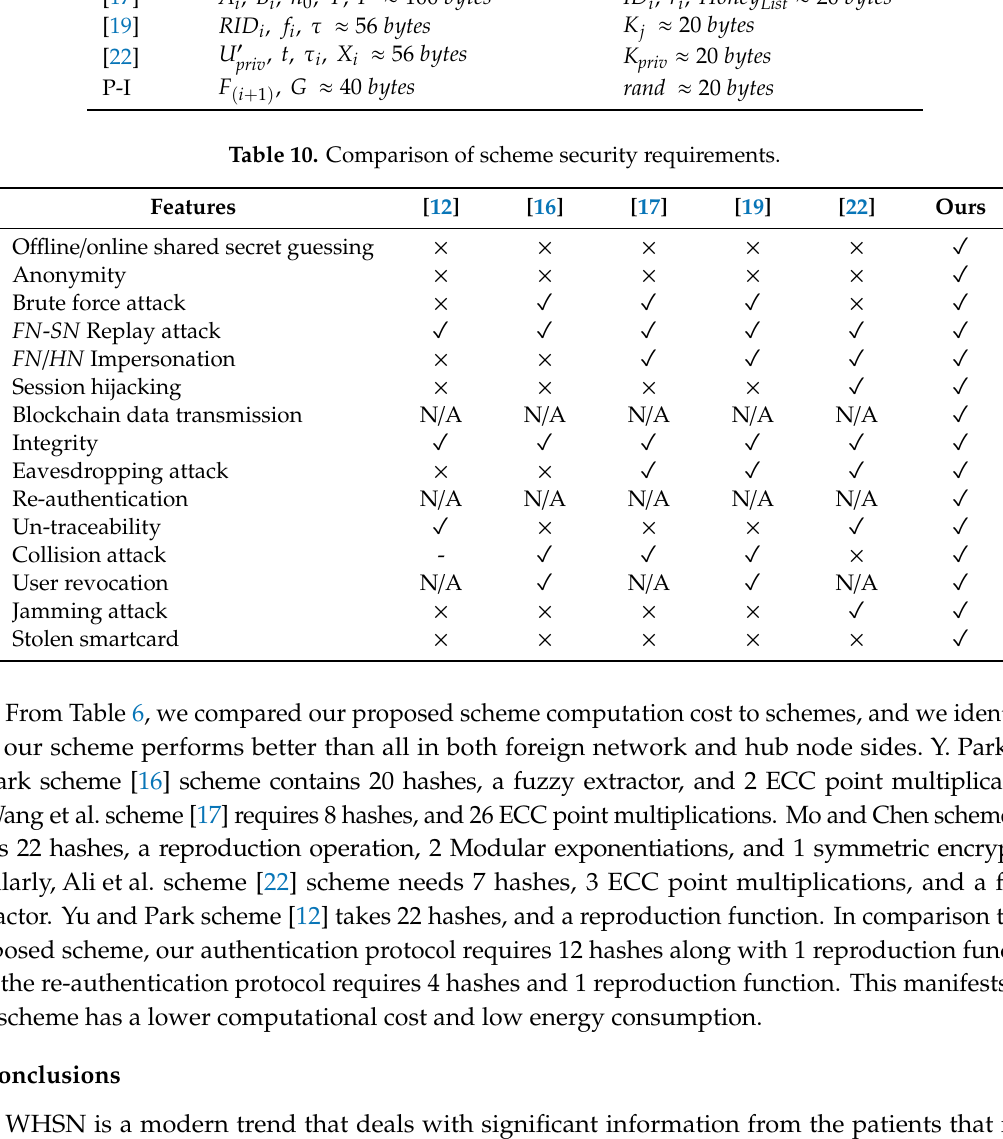
Table 9. Storage overhead computation.